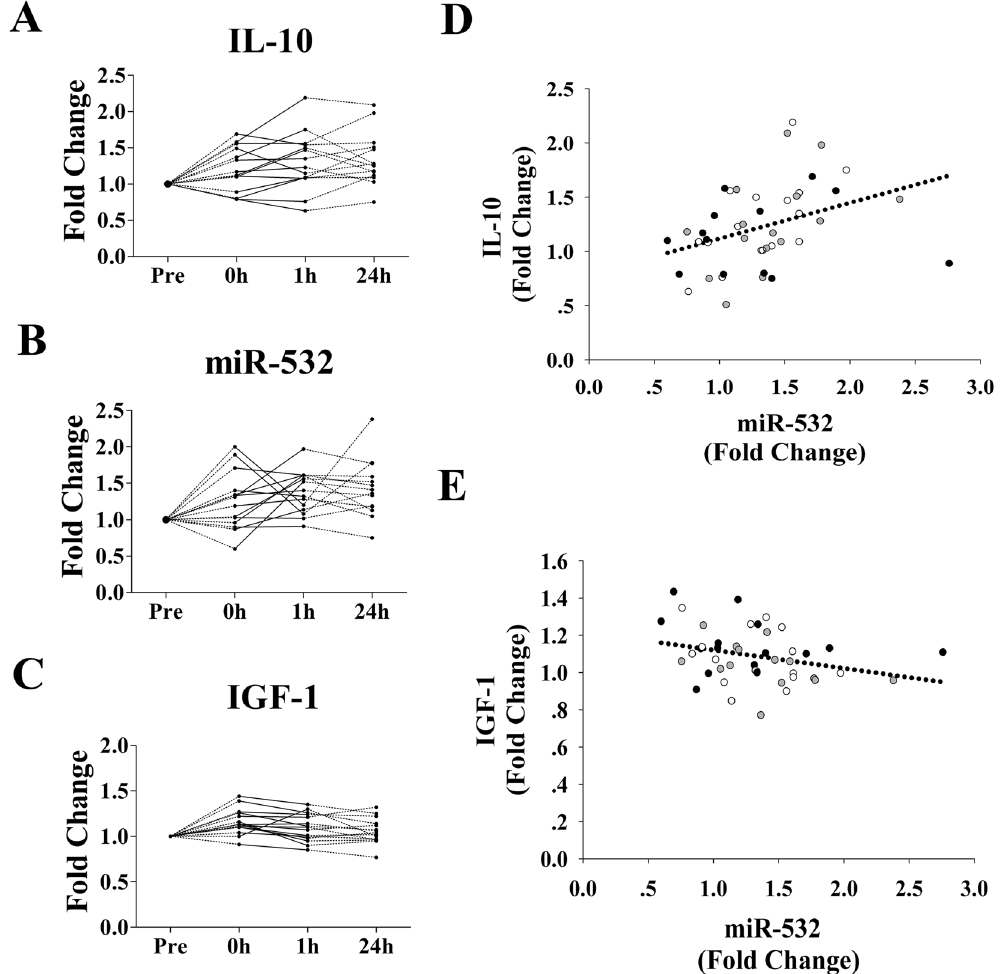
Figure 4. Alterations in miR-532 are directly correlated with changes in plasma IL-10 and IGF-1 levels (n = 15). For each subject, the plasma levels of miR-532, IL-10 and IGF-1 at baseline (Pre) were assigned a fold change of 1, and measurements obtained immediately after exercise (0 h), after 1 h of recovery (1 h) and after 24 h of recovery (24 h) were compared to the baseline. Scatterplots show the plasma levels of IL-10 ( A ), miR-532 ( B ) and IGF-1 ( C ). A direction correlation is observed between the levels of plasma miR-532 and IL-10 ( D ) and IGF-1 ( E ). The correlation analysis indicates the sum result of the three time points (black dots indicate the values for 0 h; white dots indicate the values for 1 h; and gray dots indicate the values for 24